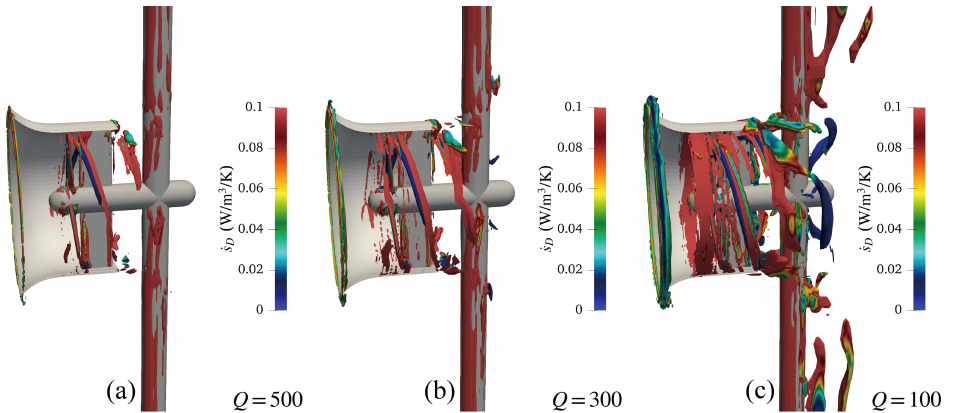
Figure 10. Vortical structure of the turbine. Isosurfaced by different Q , colored by ˙ s D ( TSR = 3.6 ) .